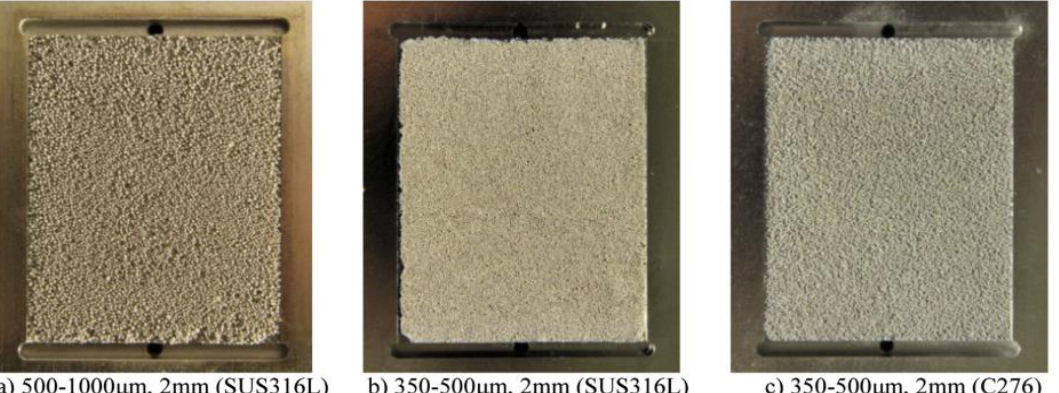
Figure 4. Porous flow fields made of sintered spherical metal powder with different grain diameter ( a ) 500–1000 µm ( b ) 350–500 µm for SUS316L steel and ( c ) 350–500 µm for C276 steel. Adapted with permission from [44], copyright 2013.